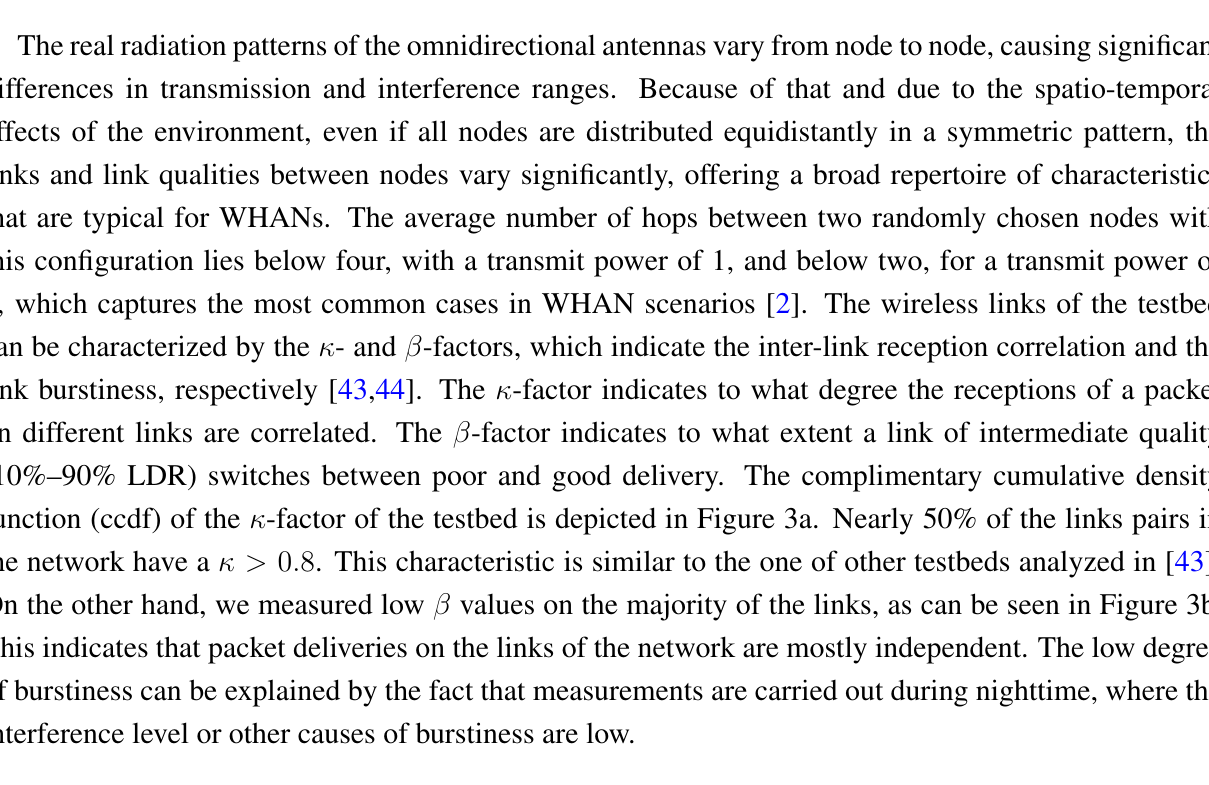
Figure 3. ( a ) ccdf of κ for link pairs in the testbed for a transmission power of about –25 dBm; ( b ) The corresponding ccdf of β for different inter-packet arrival